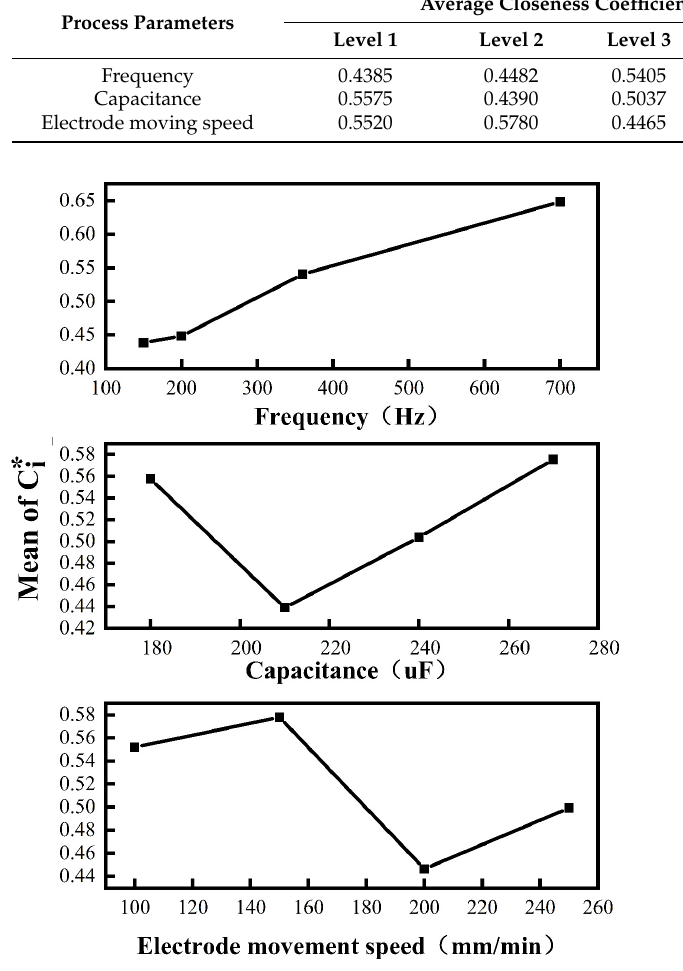
Figure 3. Mean graph of closeness coefficient 𝐶 (cid:3036)∗ .